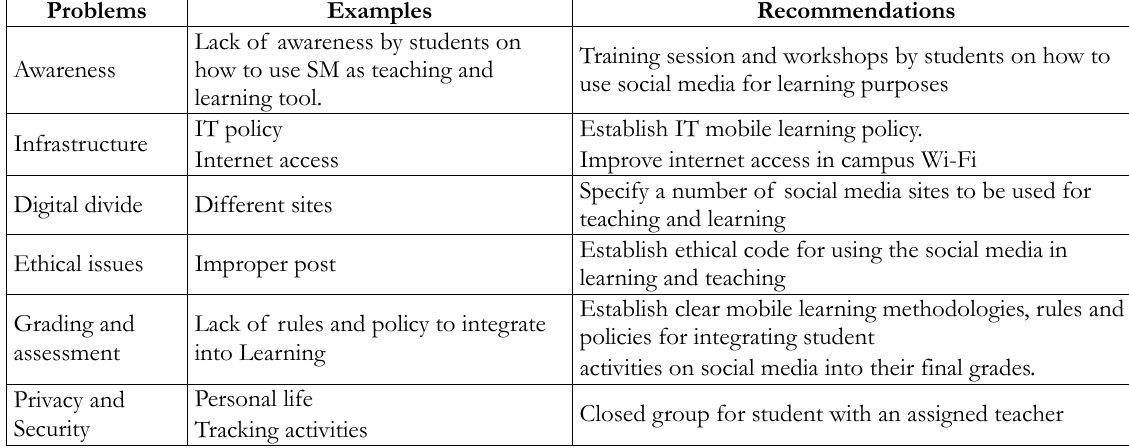
Table 6. Problems and recommendation of SM in teaching and